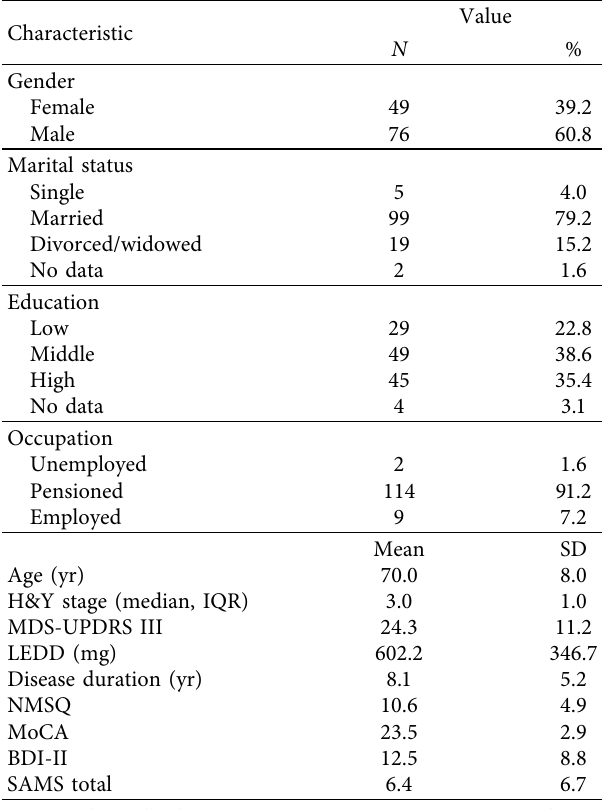
Table 1: Clinical and demographic characteristics of the patients ( n �